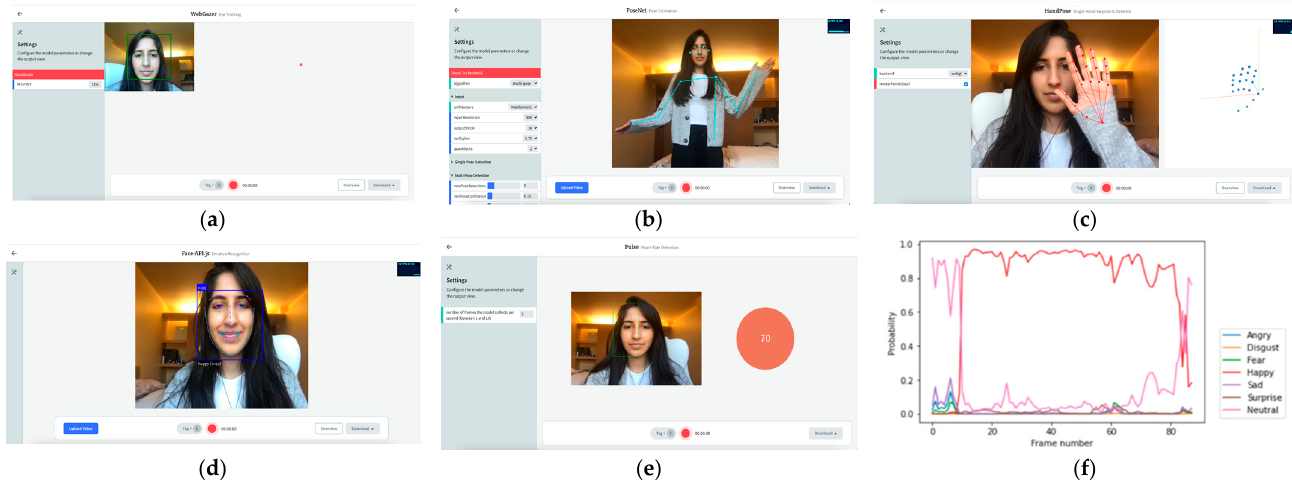
Figure 5. Screenshots of some of the tools featured on the EZ-MMLA website. ( a ) eye-tracking